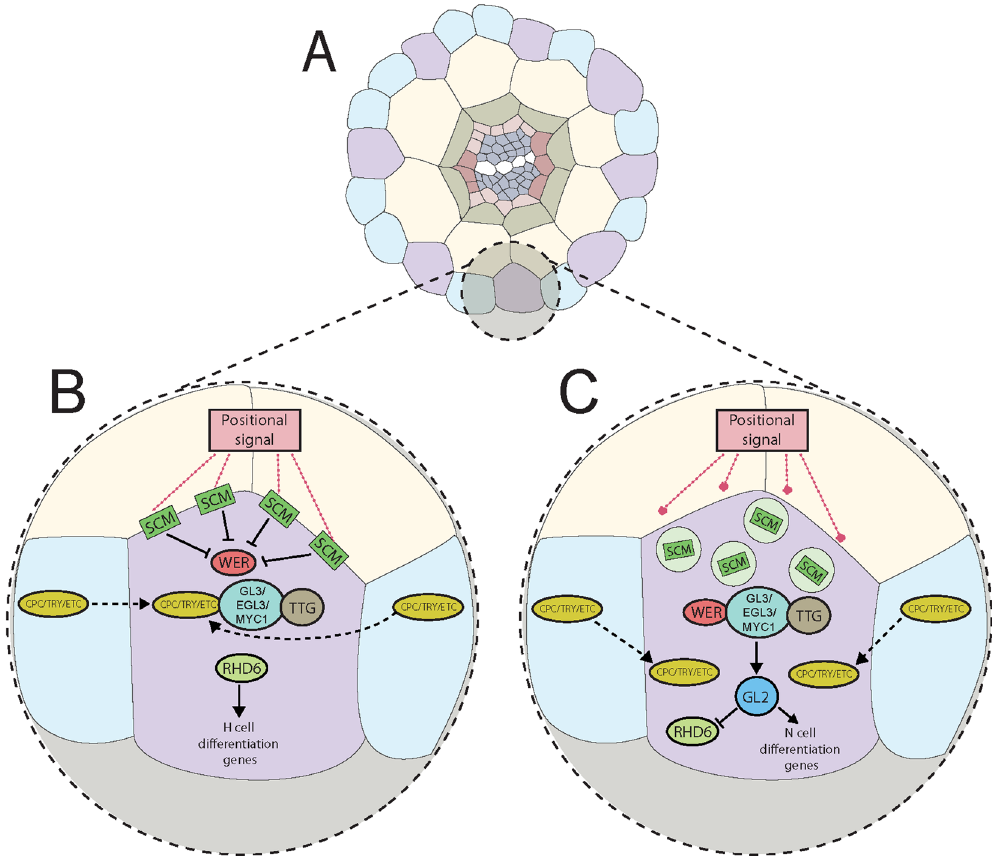
Figure 6. A model to illustrate the downstream effects of SCM mislocalization. ( A ) Diagram depicting cells from a transverse section of an Arabidopsis root. The epidermal layer comprises H cells (purple) and N cells (blue), with H cells positioned over the anticlinal walls of two underlying cortical cells (beige). ( B ) When SCM is localized to the plasma membrane, it mediates the positional signal received from the surrounding cells, consequently inhibiting the expression of WER, allowing CPC/TRY/ETC to form a transcriptional regulatory complex with GL3/EGL3/MYC1 and TTG. RHD6 is free to activate root hair (H) cell differentiation genes. ( C ) If SCM is mislocalized to the cytoplasm, the positional signal is not received. Therefore, WER is left uninhibited and competitively binds to GL3/EGL3/MYC1 and TTG, displacing CPC. This alternative transcriptional regulatory complex activates GL2, which inhibits RHD6 and activates non-hair (N) cell differentiation genes. It appears that ugt80B1 mutants represent an intermediate stage where SCM is not strictly localized at the cell periphery leading to a reduction in but not an elimination of root hair Constructs. To generate the CaMV-35S promoter GFP reporter line, the open reading frame for UGT80B1 was amplified from wild-type Col-0 genomic DNA using a DNeasy Plant Mini Kit (QIAGEN) with 5 ′ -ggggacaagt ttgtacaaaaaagcaggcttcATGGCTAGTAATGTATTTGATCATCC-3 ′ and 5 ′ -ggggaccactttgtacaag aaagctgggtCACGCCACCACATGGAAGACAACACT-3 ′ forward and reverse primers and cloned directly into the destination vector pMDC83 (Curtis and Grossniklaus, 2003). The UGT80B1:GFP reporter line with its native promoter was constructed by PCR amplification using the following: 5 ′ -TCCCCCTGCAGGCCCACCC TAATGTTTGGTCATTTGATGT-3 ′ and 5 ′ -CGGGGTACCCACCTTTAAAAACTGAATTCAACTAAACAGC-3 ′ . The PCR product was digested with Sbf I and Kpn I and ligated into the pMDC43 vector at match- ing sites to replace the CaMV-35S promoter. The UGT80B1 coding sequence was PCR ampli- fied from Col-0 cDNA using 5 ′ -GCTTGGCGCGCCCATGGCTAGTAATGTATTTGATC-3 ′ and 5 ′ -GGCCTTAATTAATCACACGCCACCACATGGAAGAC-3 ′ . The PCR product was sequenced and digested with Asc I and Pac I and cloned at the respective sites fusing the cDNA to a C-terminal GFP in the pMDC43 vector containing proUGT80B1 resulting in the ProUGT80B1: UGT80B1:GFP: construct. Both constructs were sequence verified using promoter and gene flanking primers and three nested primers: 5 ′ -CACTGTCCCGTCATTTTG-3 ′ , 5 ′ -GTGCCATTCTTTGGGGAT-3 ′ and 5 ′ -CGATGTGCAGCCTTTTCT-3 ′ . Agrobacterium tumefaciens was tranfected with destination reporter constructs which were transformed into ugt80B1 plants by floral dipping 38 . Complementation of ugt80B1 was monitored by restoring testa color 15 . UGT80B1:GFP seedlings examined for sub- cellular localization were bright homozygous lines identified from the T2 and analyzed in subsequent generations.